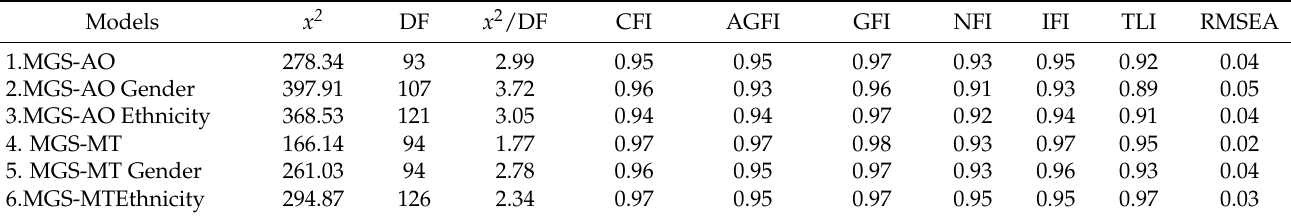
Figure 2. Structural model with Moderation of Gender in MGS and AO link. Table 5. Moderation of Gender and Ethnicity Structural